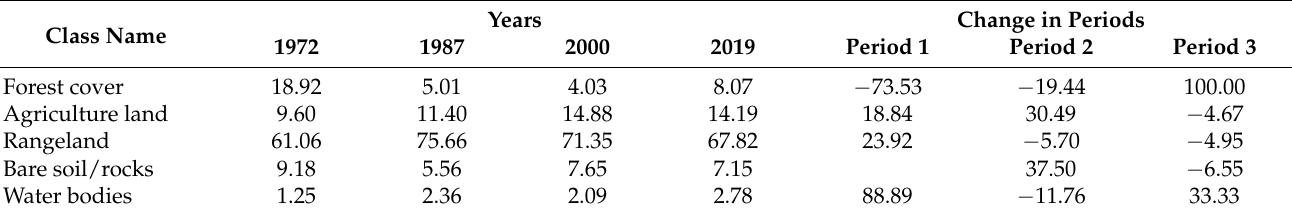
Table 6. Land use and land cover changes within 3 km of refugee camps